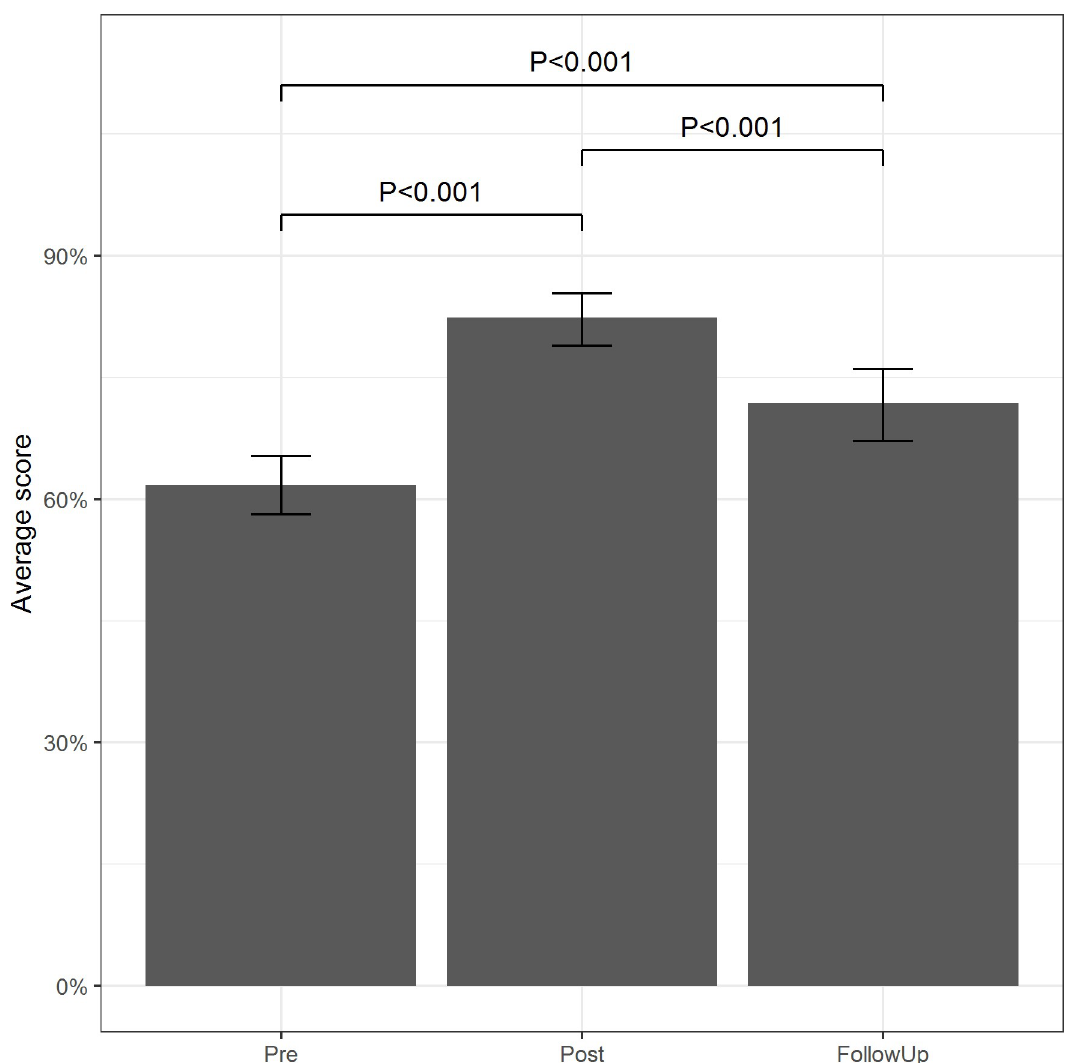
Fig 3. Average individual pupil scores for QS2 at each of the three assessment points. Statistical significance between time points is indicated by the